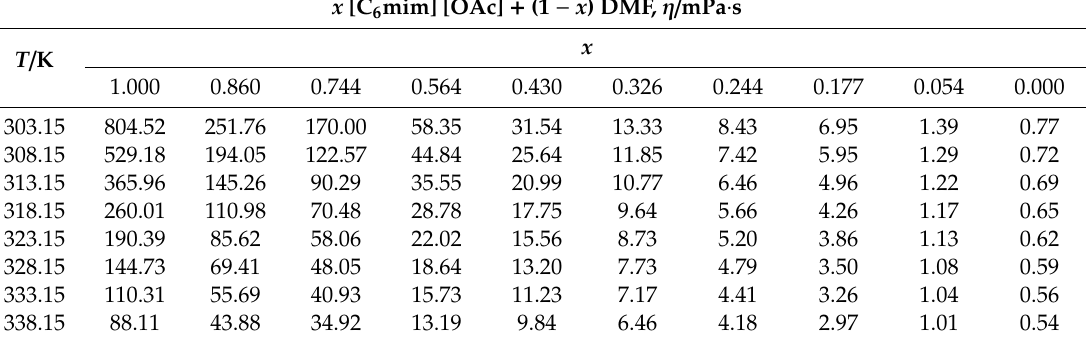
Table 11. Experimental viscosities of [C 6 mim] [OAc] with DMF at (0.0967 ± 0.002) MPa from 303.15 to 338.15 K and x is IL mole fraction.